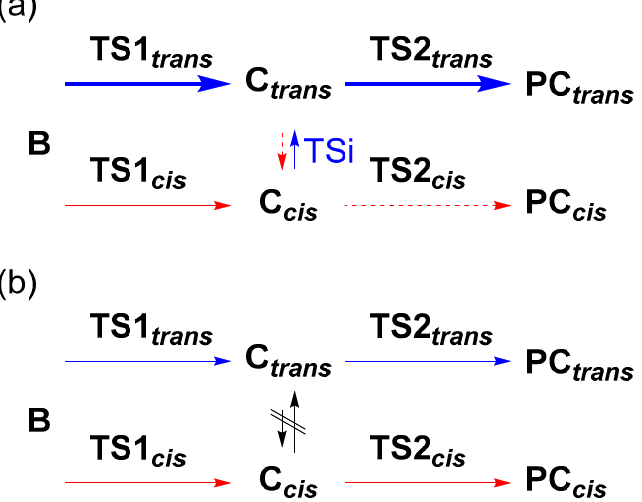
Table 2. The calculated Gibbs free energies Δ G and activation energy E a (in